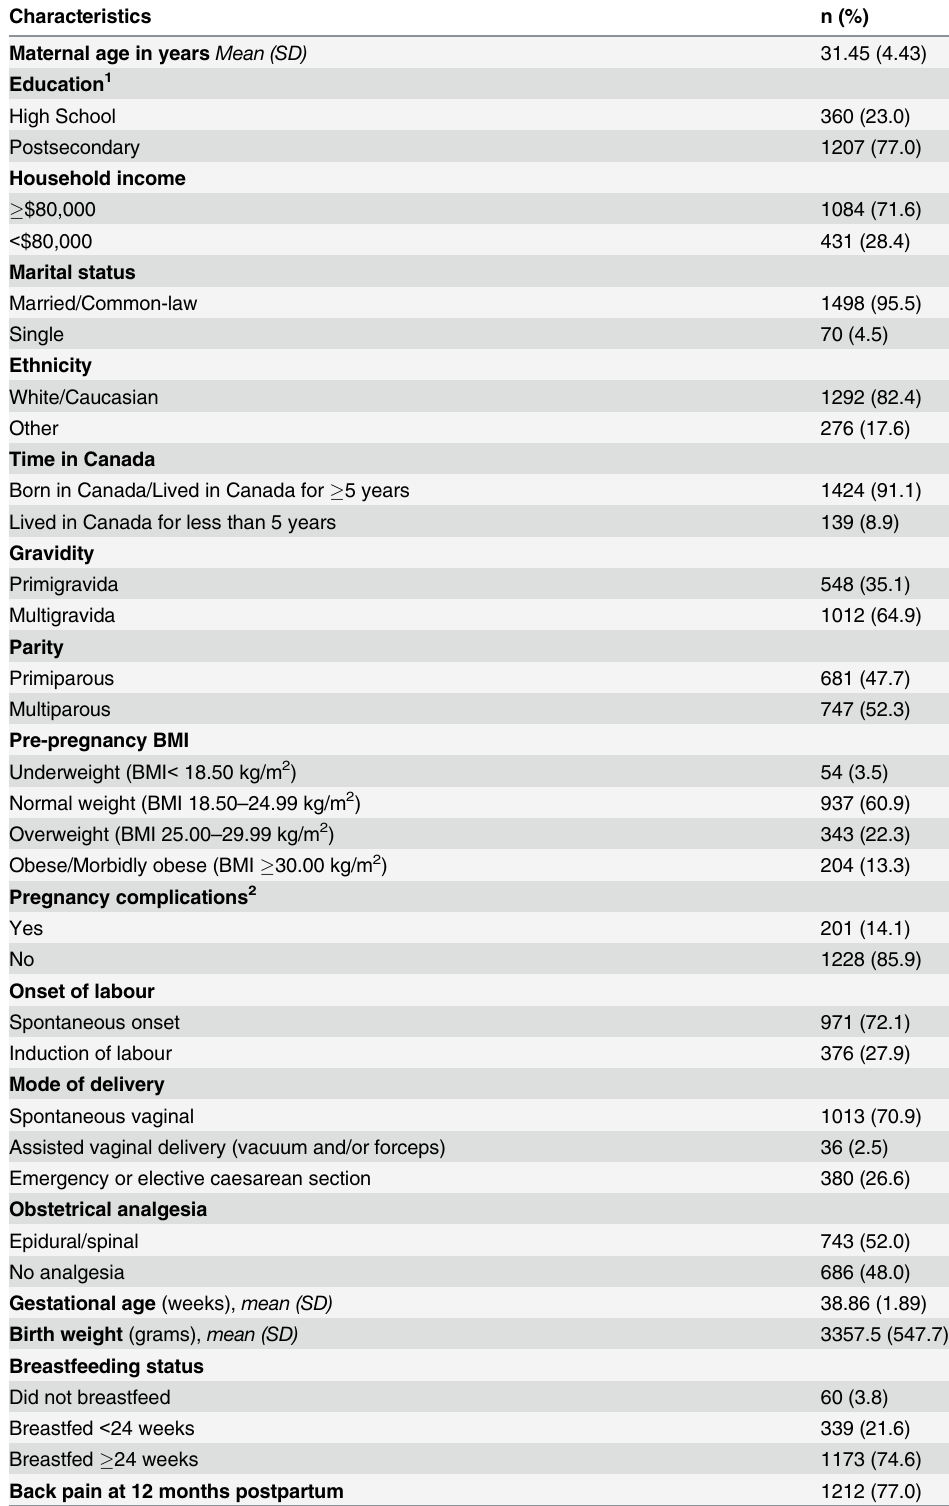
Table 1. Characteristics of the study participants (N =